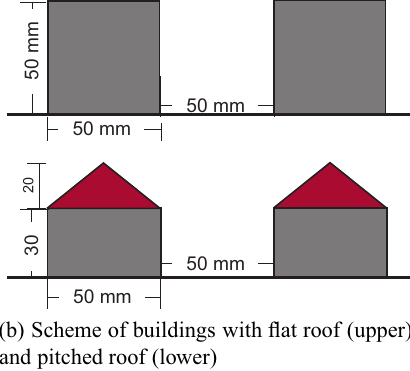
Fig. 1: Scheme of the experimental set-up.